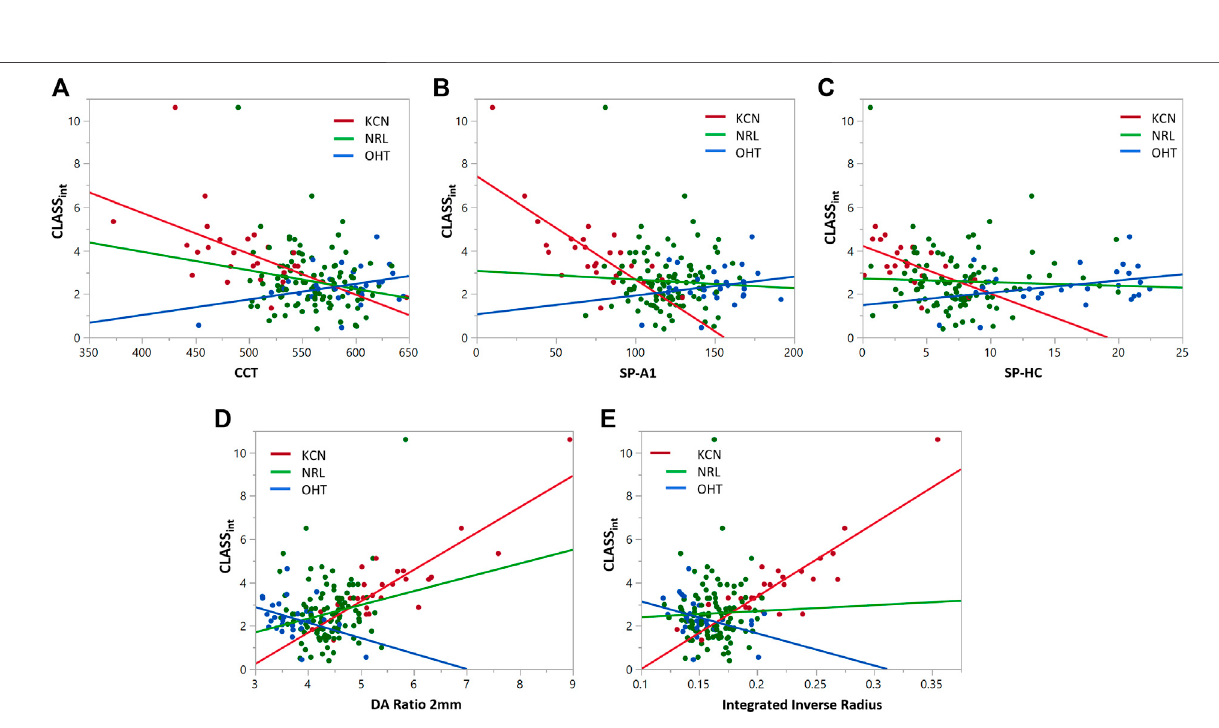
Frontiers in Bioengineering and Biotechnology |